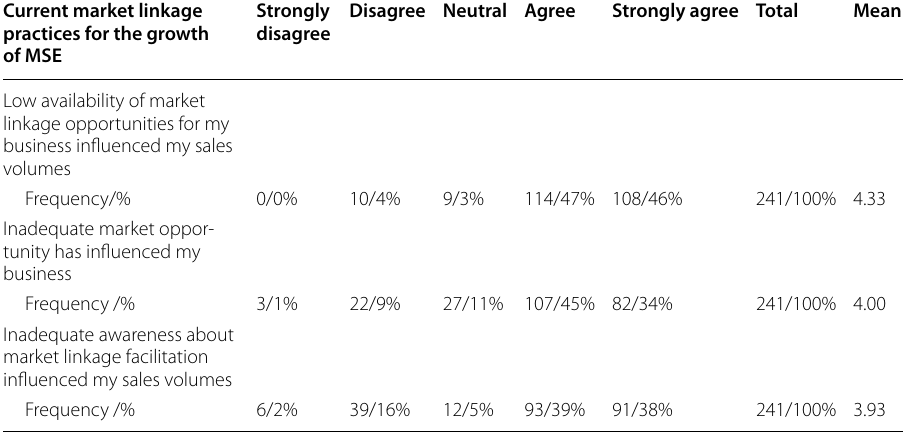
Source: Survey data, 2019